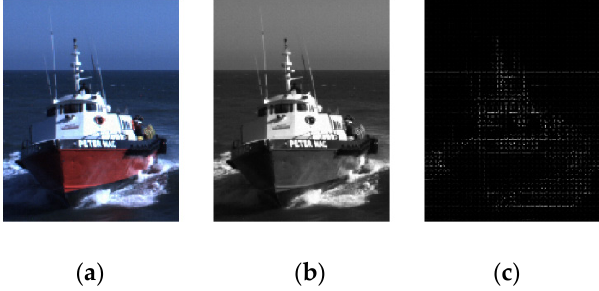
Figure 8. Illustration of HOG feature using the VAIS dataset: ( a ) Original image; ( b ) grayscale image; and ( c ) HOG feature.